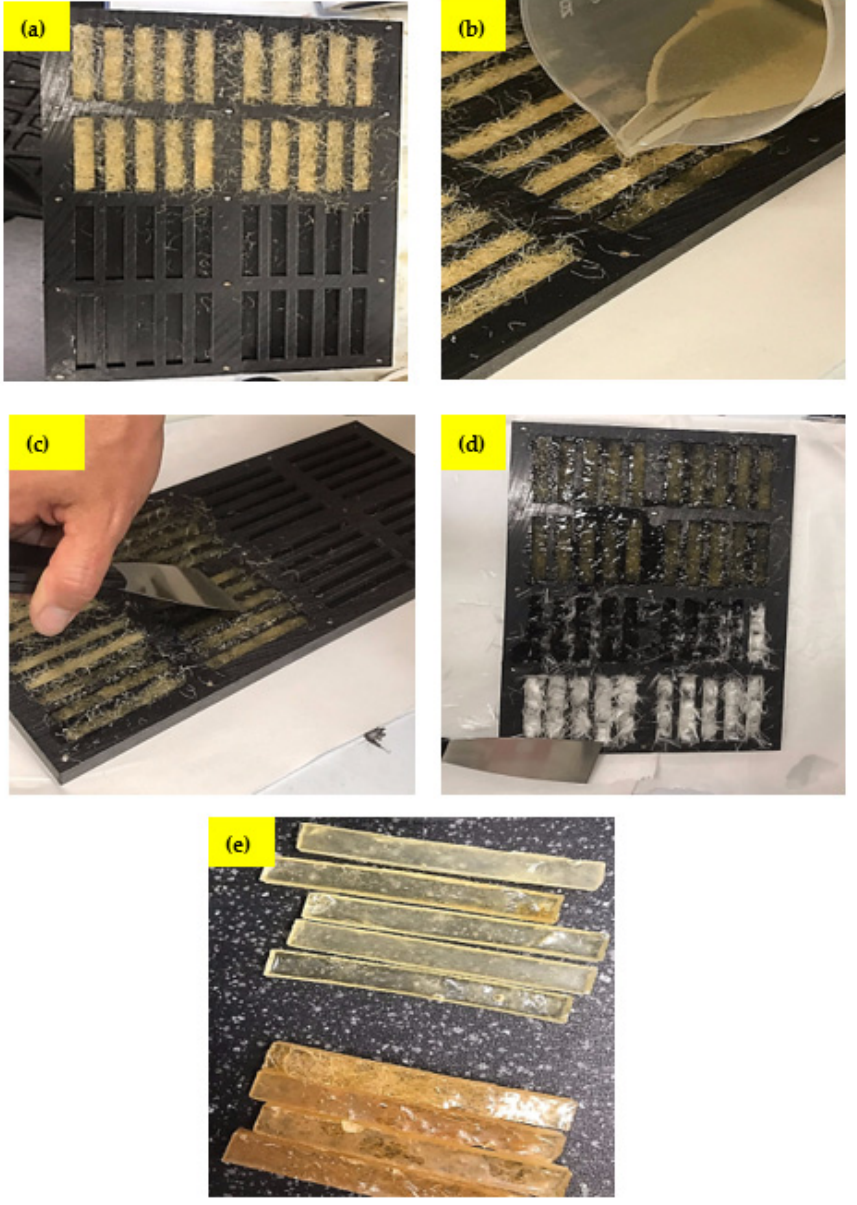
Figure 5. Different stages of composite fabrication ( a ) fibre aligned in the mould ( b ) epoxy with hardener pour into the mould ( c , d ) trap air removal ( e ) cured samples.